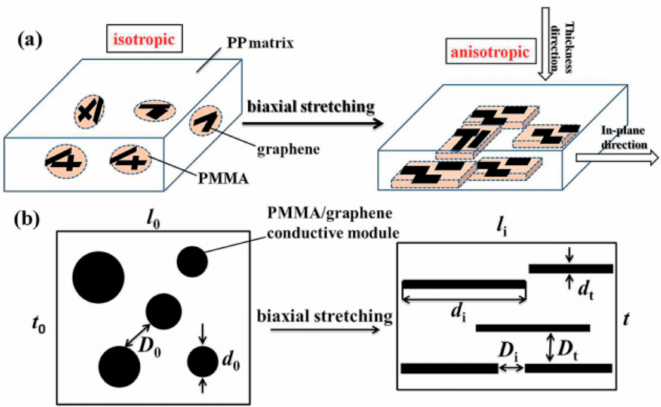
Figure 9. ( a ) Morphology transformation of GRPCs during biaxial stretching; ( b ) Sectional view of (a). Reproduced with permission from [121]. Copyright 2017, The Royal Society of Chemistry.